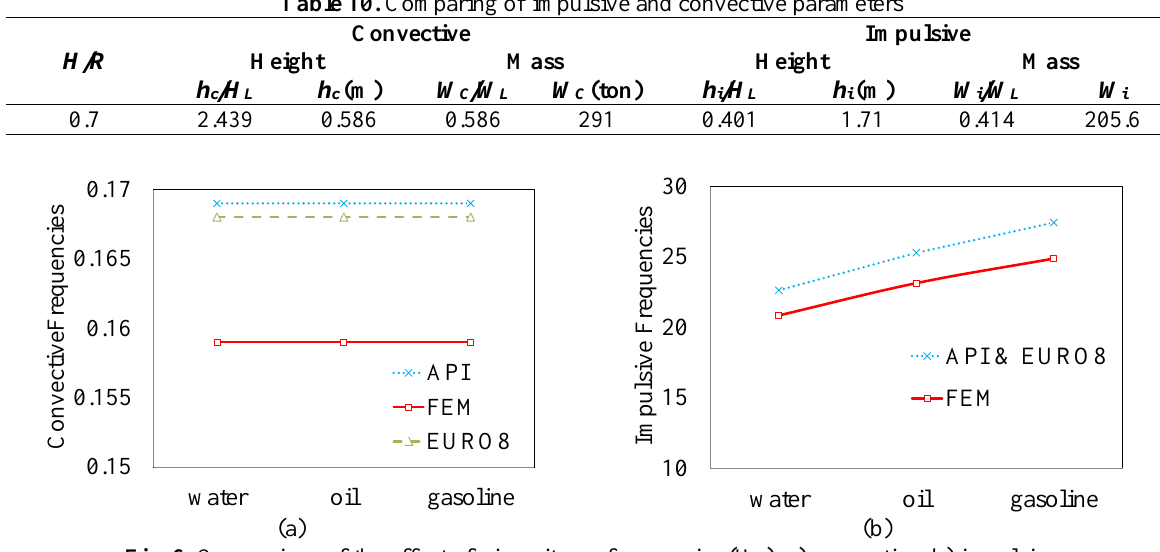
Table 9. Comparing of impulsive and convective frequencies (effect of viscosity)